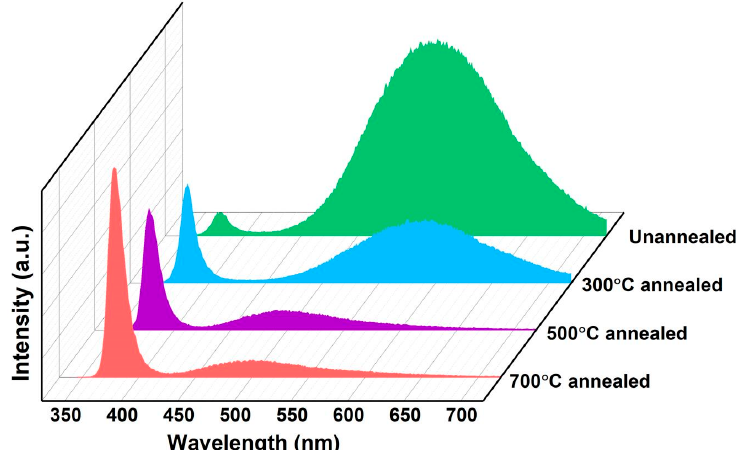
Figure 4. PL spectra of ZnO NRs at different annealing temperatures.